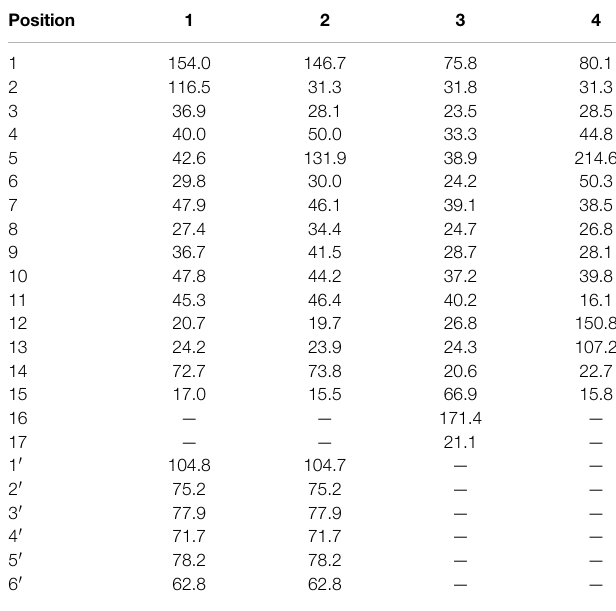
TABLE 2 | 13 C NMR data of compounds 1 and 2 in CD 3 OD and of compounds 3 and 4 in CDCl 3 (125